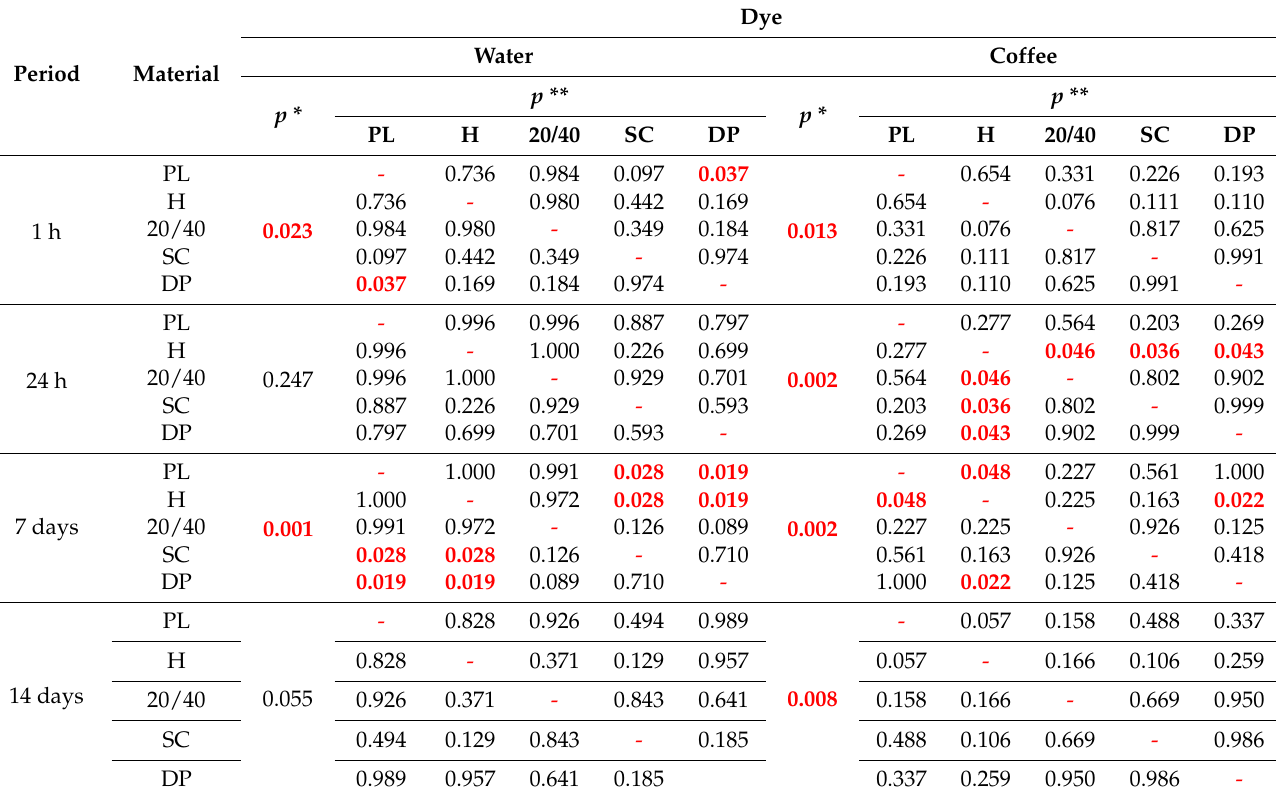
Figure 5. Mean color change ∆ E* after storage in red wine. The graphical visualization of the color change ∆ E* observed after the 14-day incuba- tion period in relation to the type of brackets and sample storage environment is presented in Figure 6. Table 7. Comparisons of ∆ E* between materials within dye (water, coffee) and period